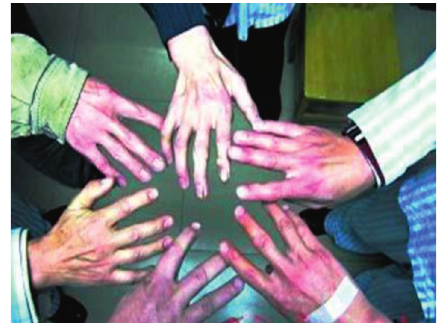
Figure 1: Symptoms and signs of vibrating white